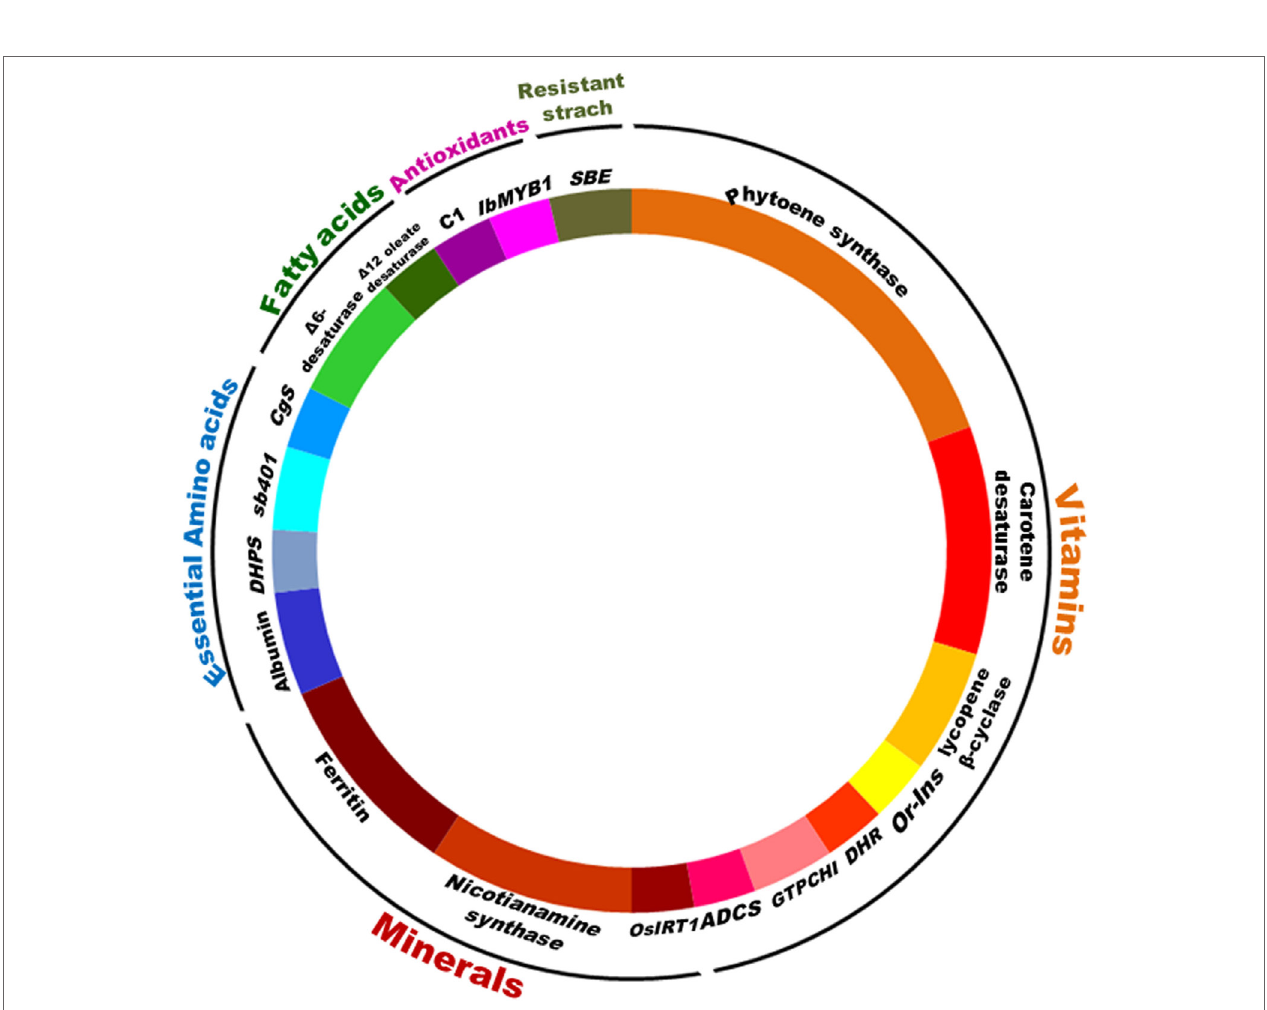
FiGURe 4 | Utilization of different genes for biofortification by transgenic means. Large numbers of genes have been utilized for crop biofortification. Transgenic- based approach has advantages that a useful gene once discovered, can be utilized for targeting multiple crops. Some important genes like phytoene synthase, carotene desaturase, nicotinamide synthase, and ferritin have been utilized in multiple events including multiple